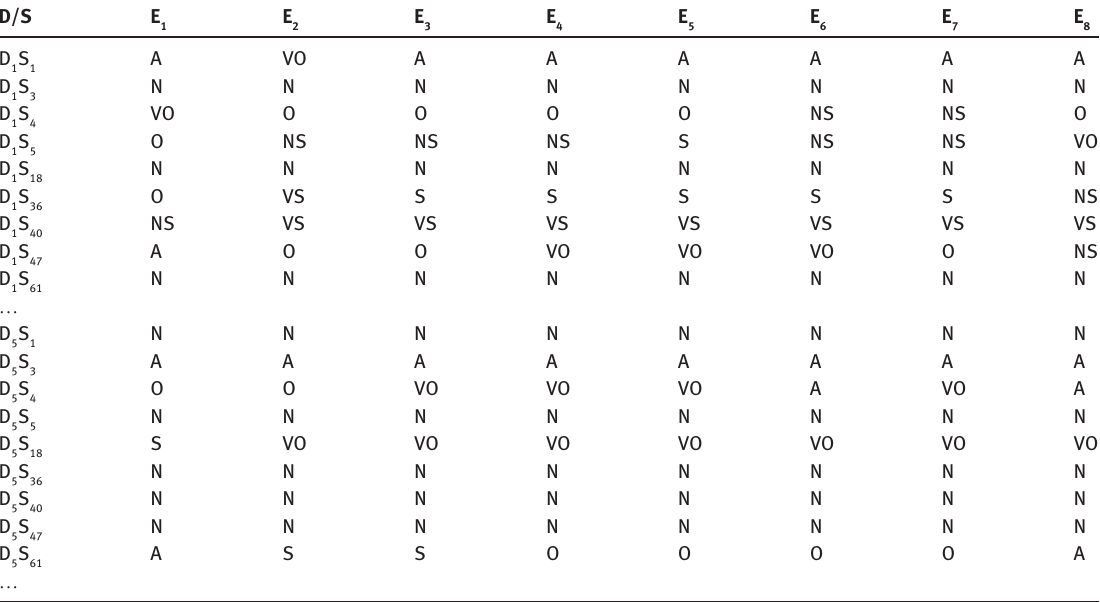
Table 1: Disease/Symptom and Experts Confirmation Values. D/S